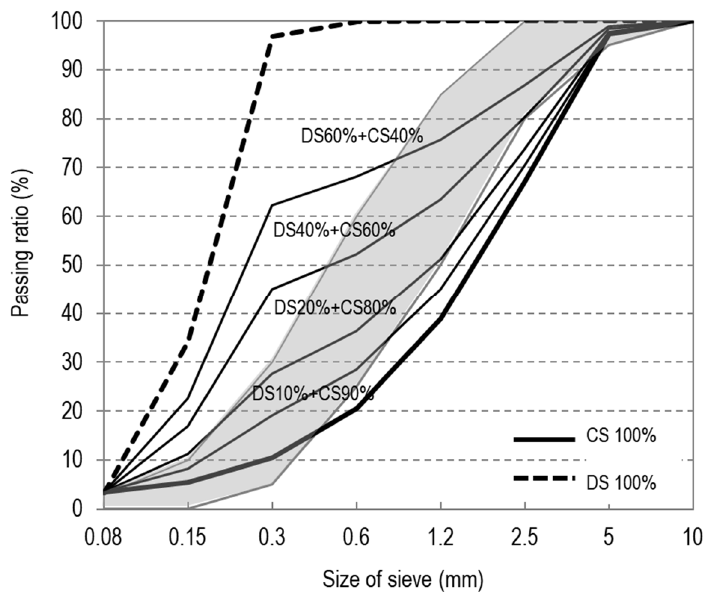
Figure 1. Particle-size distributions of the FAs used in this study.